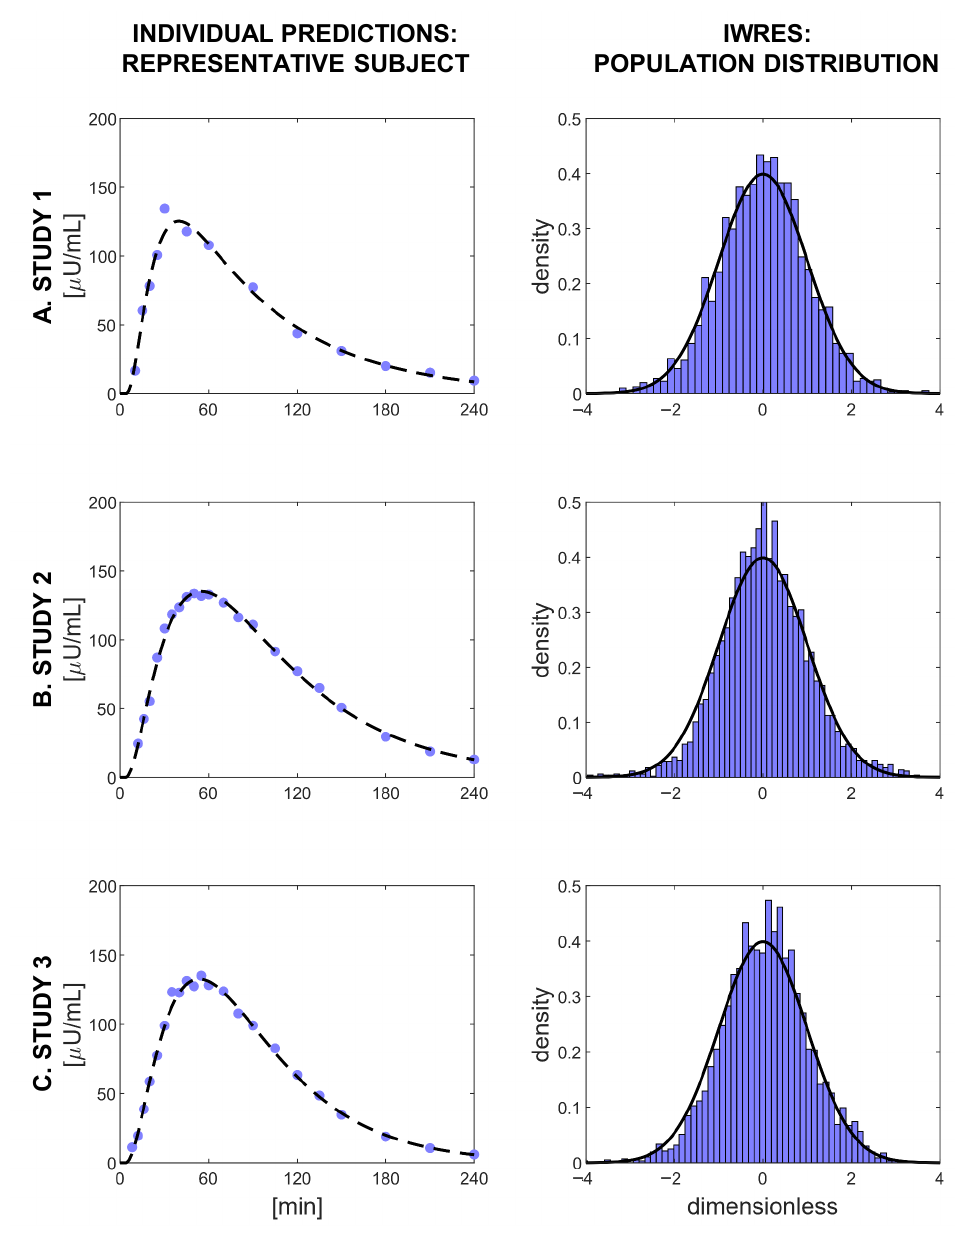
Figure 4. Evaluation of the goodness of the predictions of Model 11. Left panels: the fit of the model for three representative subjects, one for each study. Blue dots indicate plasma insulin measurements, and black dashed lines represent the model predictions. Right panels: the distributions of the IWRES in each study, compared with a standard Gaussian distribution (black